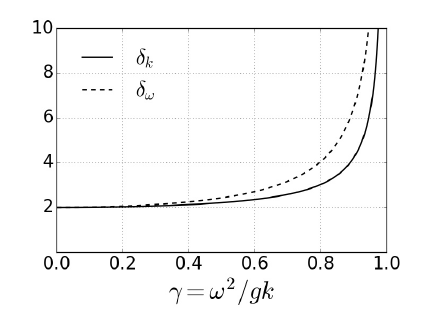
Figure 13. Propagation of the errors in k and ω to water depth h when using the dispersion